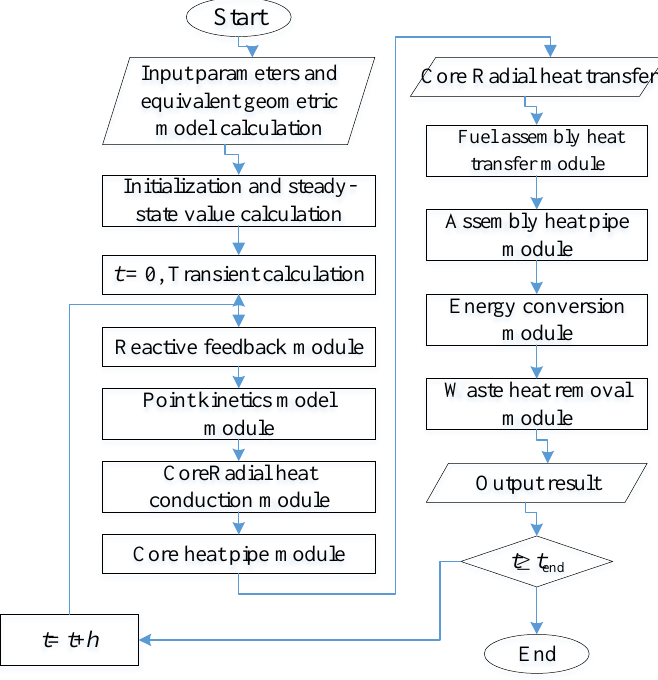
Figure 9. Schematic of TAPIRSD code.